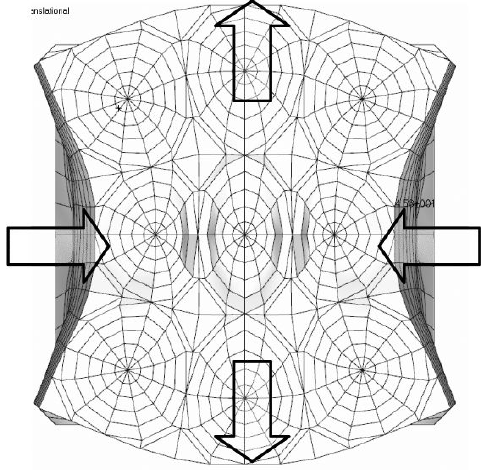
Fig. 30. 7th mode: − 1248 Hz (1407 Hz – Quad-cell).